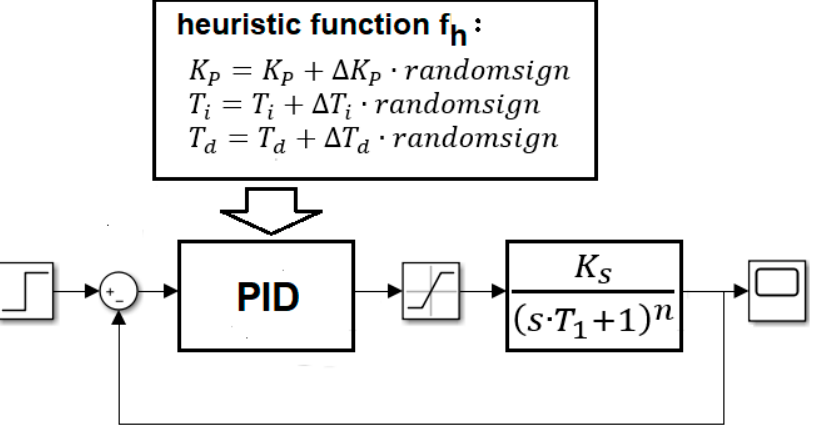
Figure 4. Heuristic function of hill-climbing method, acting on the PID controller parameters.